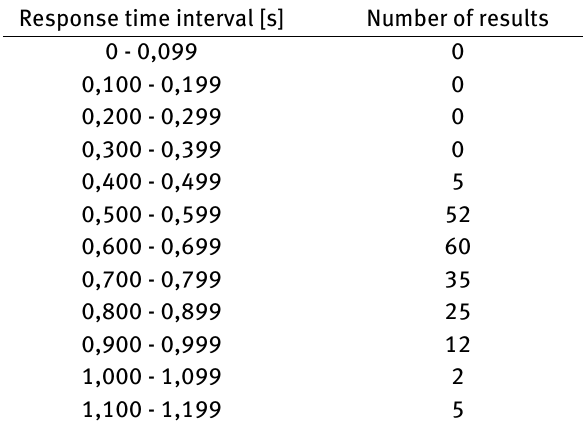
Table 22: Distribution of results in the individual response time intervals.